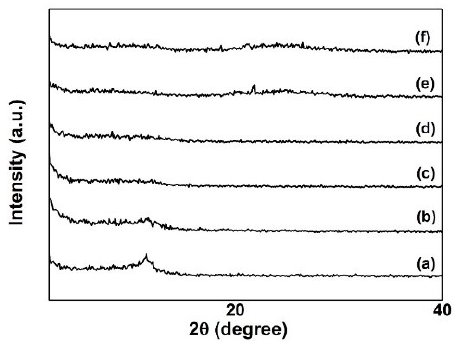
Figure 7. XRD spectra of ( a ) GO; GO electrochemically reduced at ( b ) 5 V; ( c ) 10 V; ( d ) 15 V; ( e ) 20 V; and ( f ) 25 V.